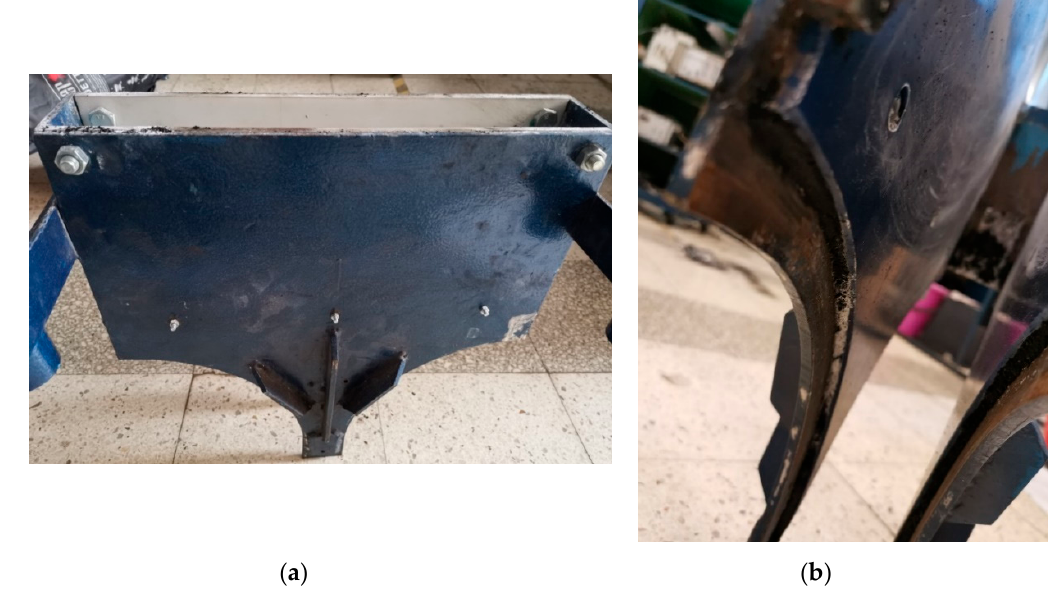
Figure 5. Photograph of the interior of the gravity feeder with installed boards made of the material: ( a ) POM C and ( b ) UHMW-PE.